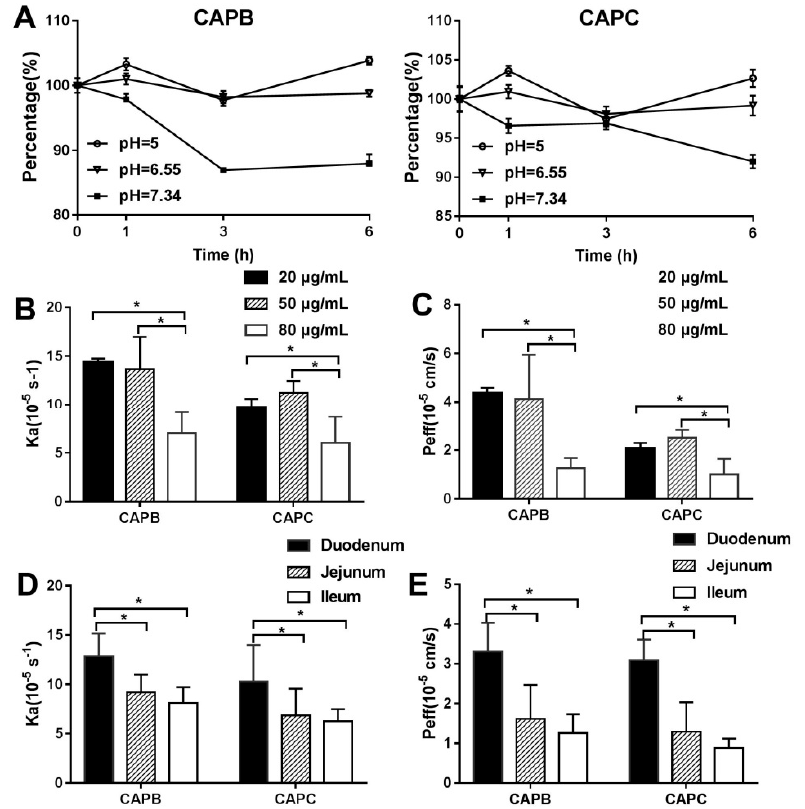
Figure 4. The characterization of the intestinal permeability of capilliposide B (CAPB) and capilliposide C (CAPC) in single-pass intestinal perfusion (SPIP) model. The stability of CAPB and CAPC were measured at different pH values (pH 5, pH 6.55, and pH 7.34, respectively) ( A ). The absorption rate constants (ka, s − 1 ) values ( B ) and effective permeability (P eff , cm/s) values ( C ) for CAPB and CAPC at different initial drug concentrations (20 µ g/mL, 50 µ g/mL, and 80 µ g/mL, respectively). p < 0.05 (*) compared with with the group at 80 µ g/mL. The Ka values ( D ) and P eff values ( E ) of CAPB and CAPC obtained from the duodenum, jejunum, and ileum in SPIP models. p < 0.05 (*) compared with the duodenum. All the results are expressed as mean ± S.D. (n = 3).